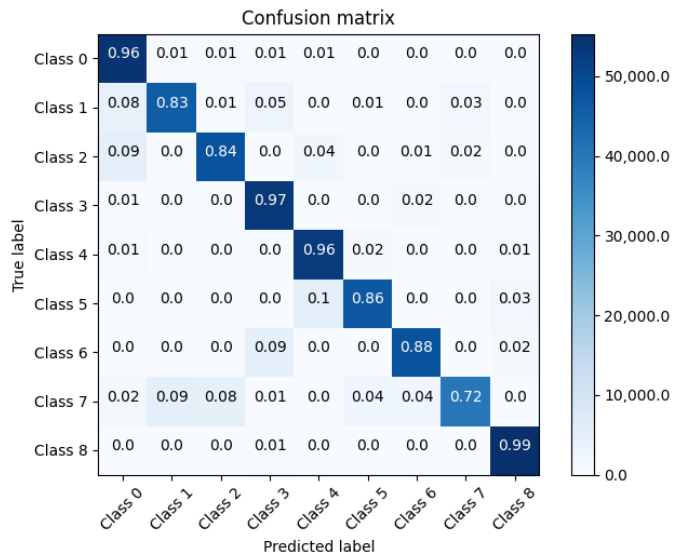
Figure 16. Confusion matrix for the three-tank